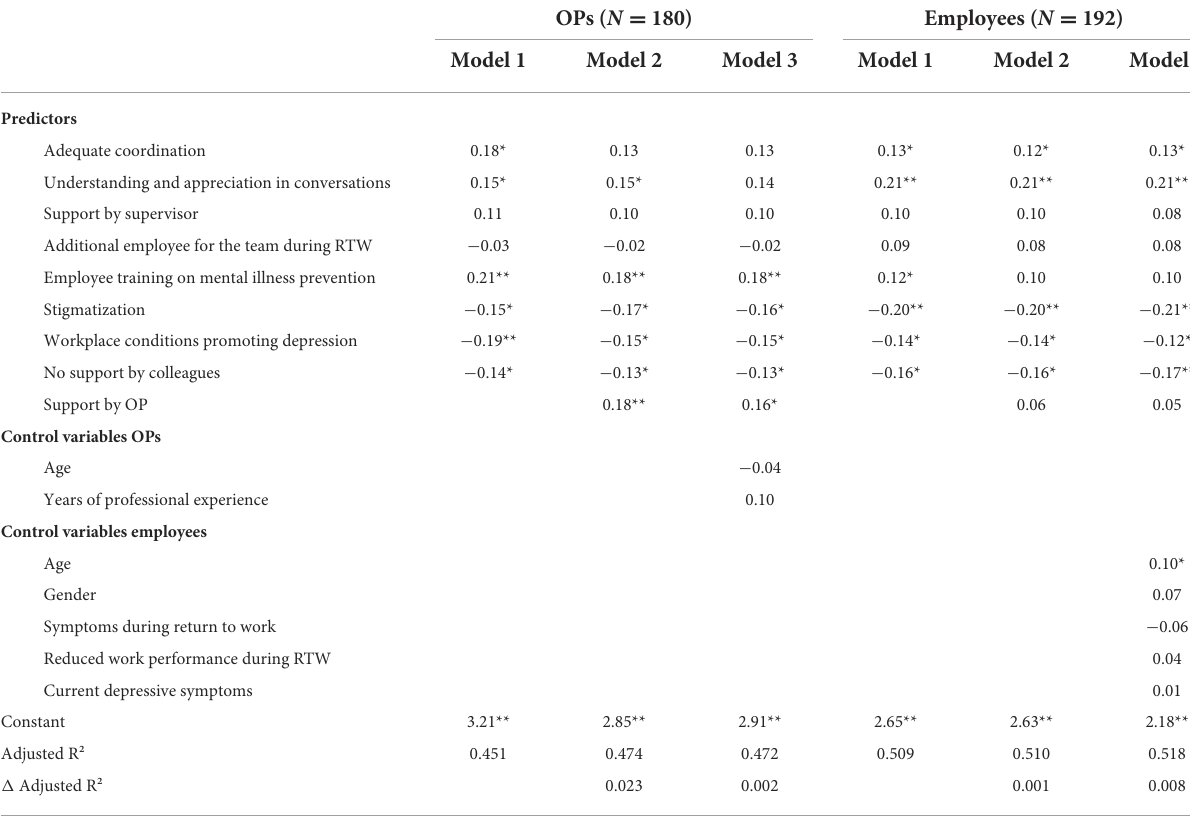
TABLE 2 Standardized regression coefficients for RTW rating separated by OPs and